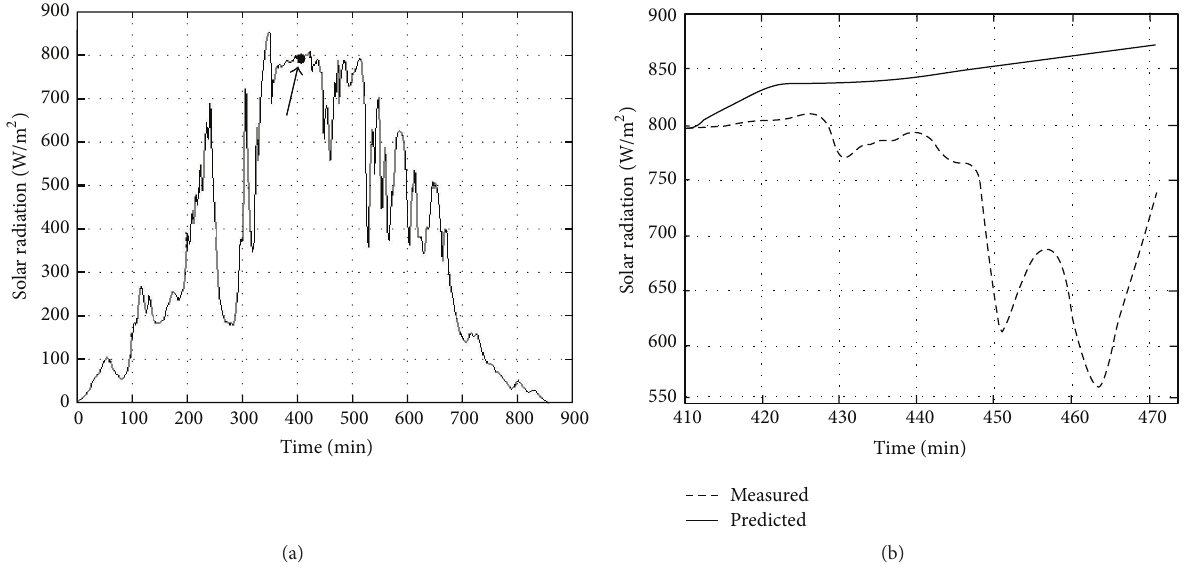
Figure 4: In (a), the solar radiation measured at the 8 of July of 2001. In (b), the solar radiation sixty-step ahead prediction, from the point identified in (a), using a 10th order AR model.